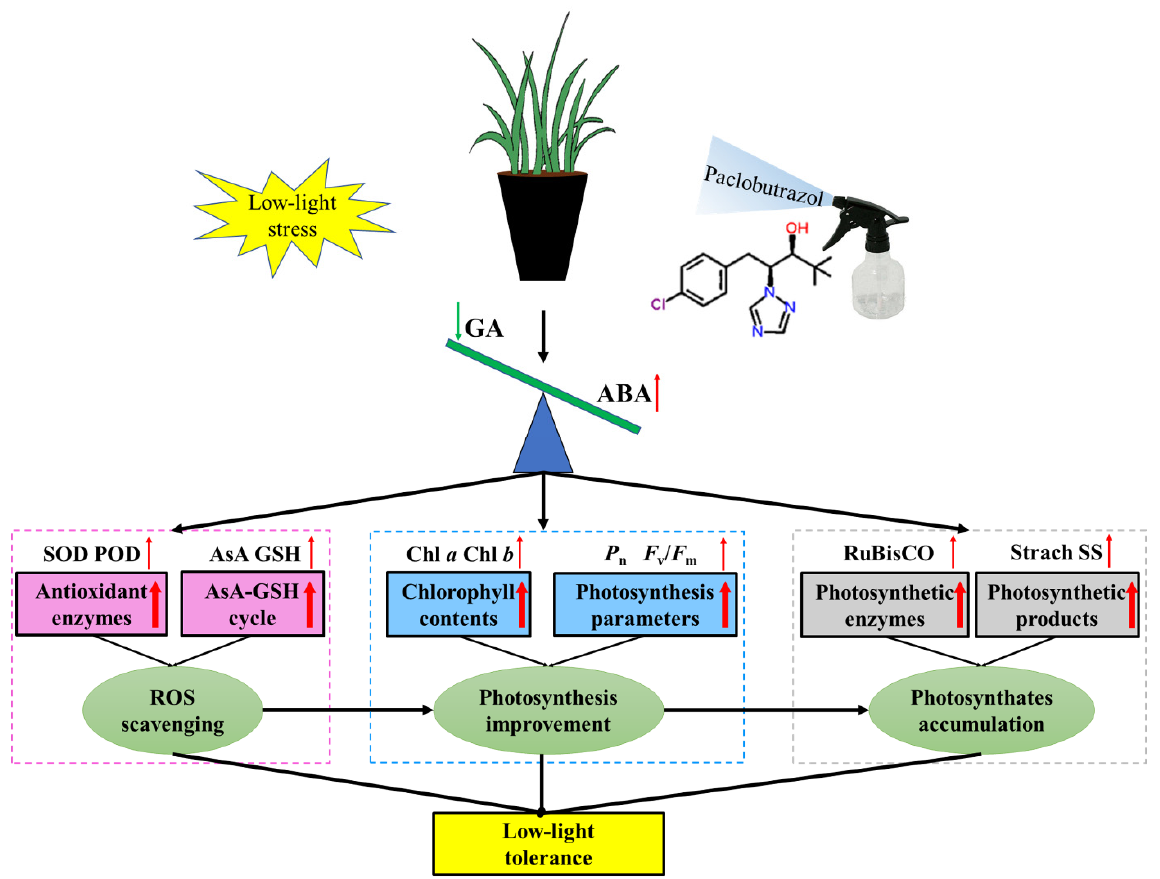
Figure 10. The diagram of PBZ in improving LL tolerance of tall fescue seedlings. SOD = superoxide dismutase, POD = peroxidase, AsA = ascorbic acid, GSH = reduced glutathione, Chl a = chlorophyll a , Chl b = chlorophyll b , P n = Net photosynthetic rate, F v / F m = maximum quantum yield of photosystem II photochemistry, SS = soluble sugar. Red and green arrows indicated rise and fall, respectively.